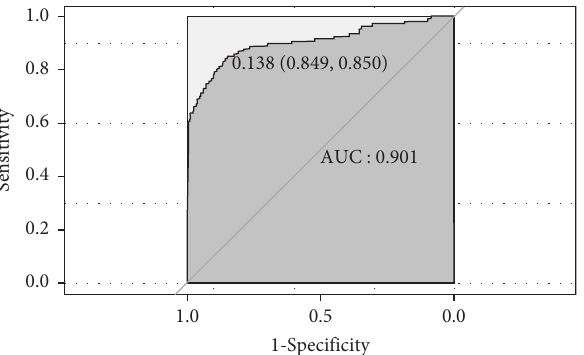
Figure 2: ROC curve for month one.